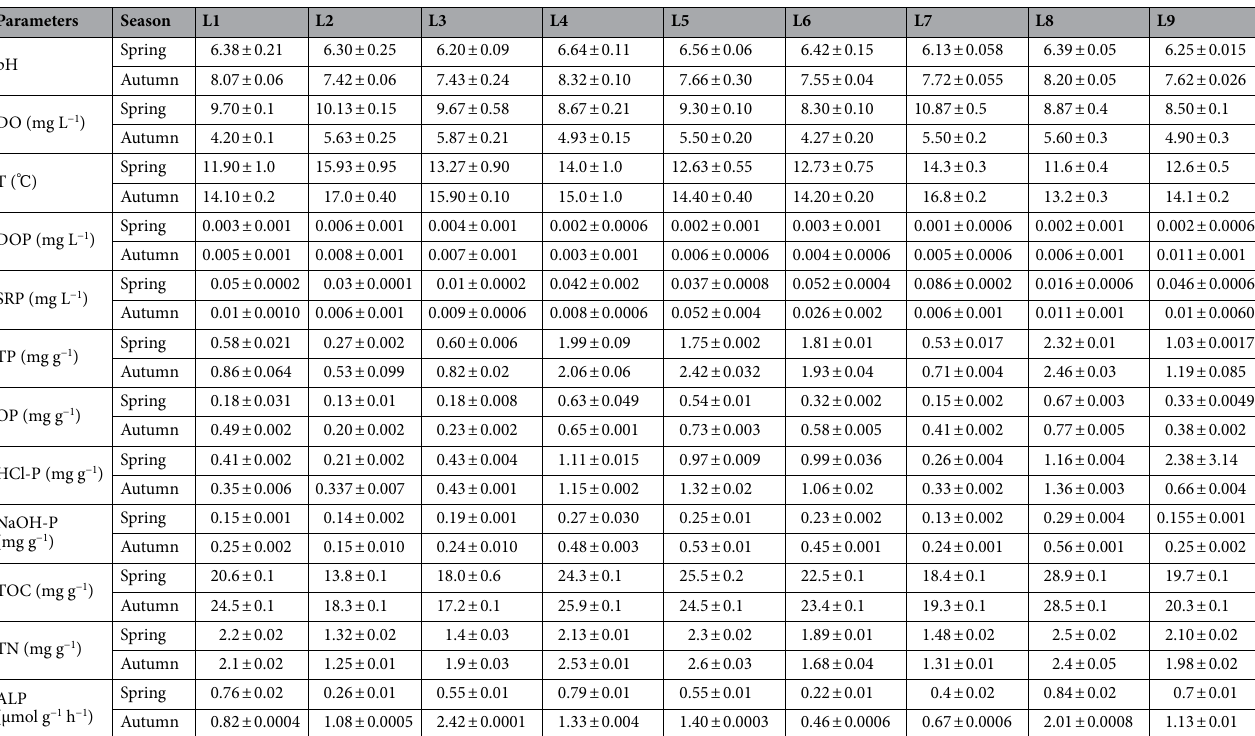
Table 1. Physicochemical properties of the sediments and overlying water in spring and autumn. DO, T, DIP, and DOP were measured in overlying water of sediments. pH, TOC, TN, TP, OP, HCl-P, NaOH-P, and ALP were measured in sediments. Data are mean ± standard